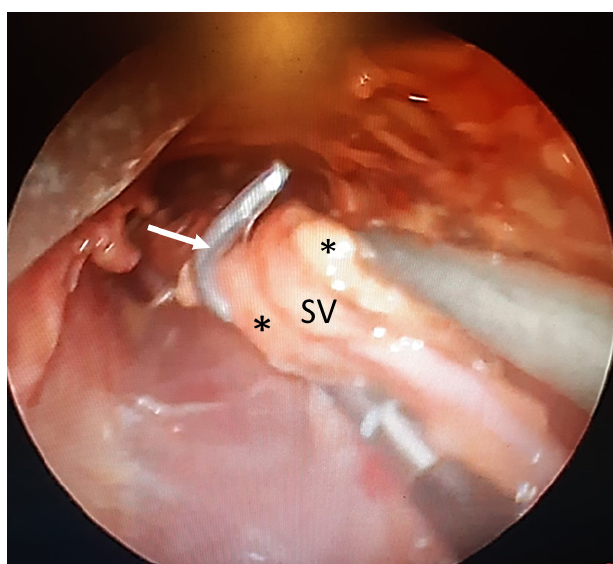
Fig. 4 - No-touch endoscopic saphenous vein (SV) graft harvesting. Screen shot from a video footage taken at harvesting where perivascular adipose tissue (*) remains intact surrounding the SV. (From Hayashi et al. [60] ,